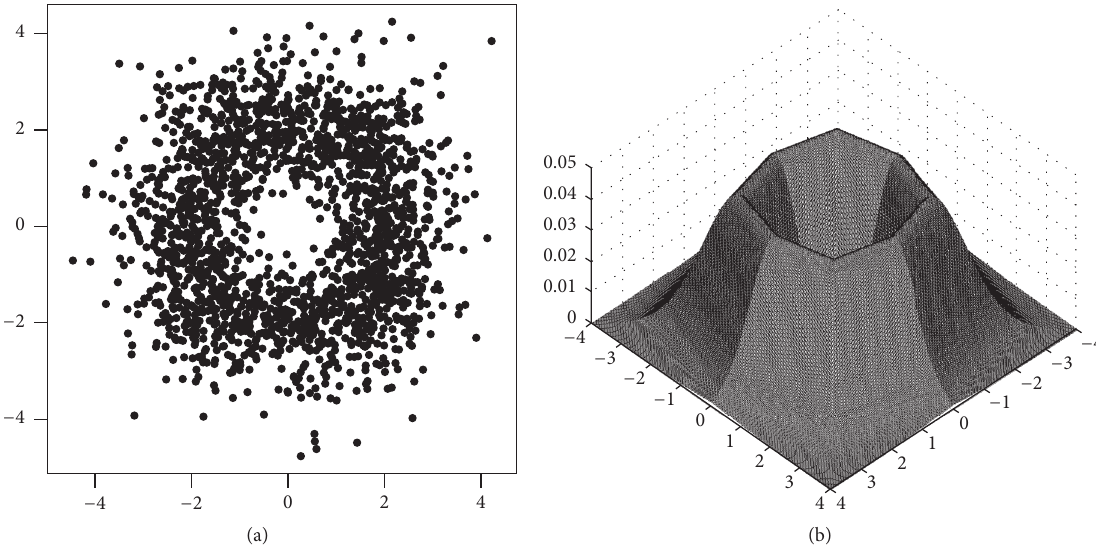
Figure 5: 2000 points (a) simulated according to 𝜑 𝑔